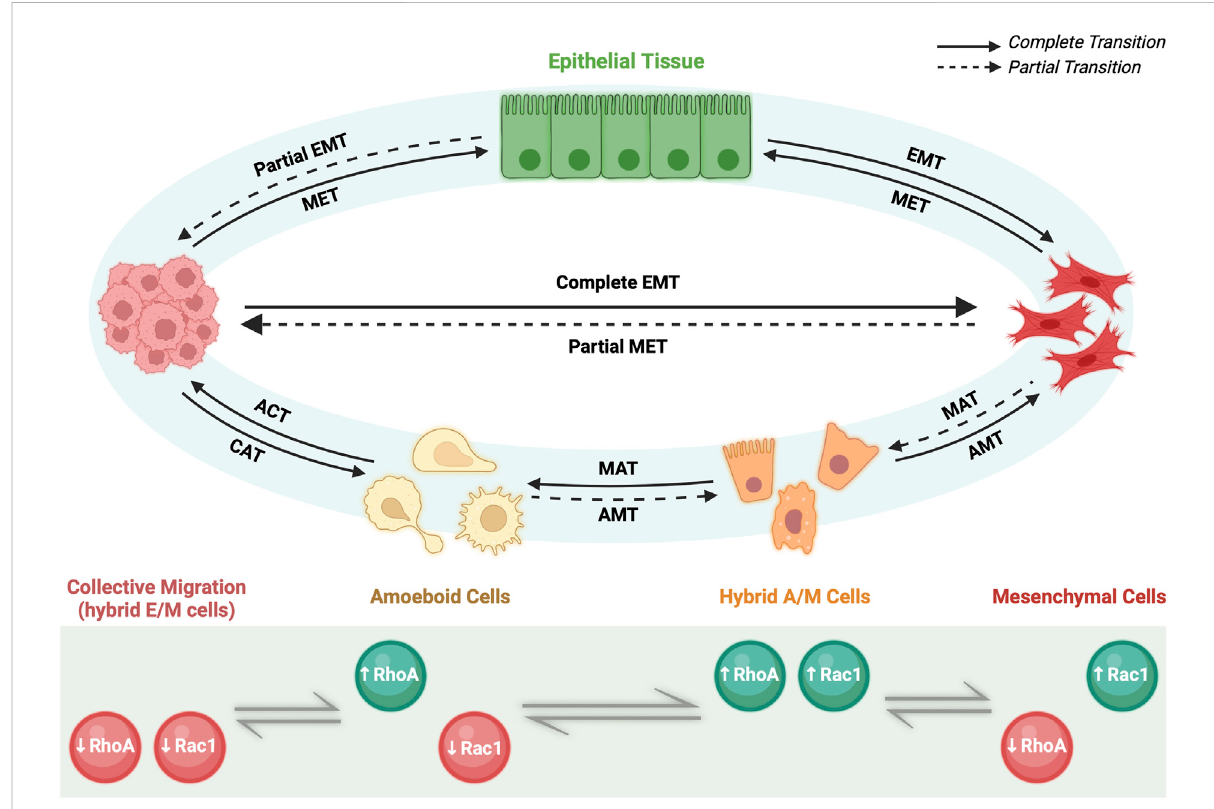
FIGURE 3 Migratory plasticity. Primary epithelial tissue through partial EMT (pEMT) and complete EMT can give rise to motile cells capable of invasion via collectivemigrationofhybridE/Mcellsorindividualmigrationofmesenchymalcells,respectively.Afterwards,speci fi cmicroenvironmentconditions govern reversible cell fates. On one hand, cluster of hybrid E/M cells can undergo collective-individual transition either by completing EMT process and becoming mesenchymal cells or via collective-amoeboid transition (CAT) and giving rise to amoeboid cells. The reverse process is called amoeboid-collective transition (ACT). Amoeboid and mesenchymal cells can reversibly interchange phenotype via amoeboid-mesenchymal (AMT) and mesenchymal-amoeboid transition (MAT), respectively. Partial AMT and partial MAT give rise to hybrid A/M cells with mixed amoeboid and mesenchymal features. On the other hand, mesenchymal cells via pEMT can either undergo individual-collective migration giving rise to a cluster of migratory hybrid E/M cells or revert their phenotype via MET and becoming epithelial cells. All the transitions rely on thelevels of two small GTPases, RhoA and Rac1, which can be upregulated (green) or downregulated (red) depending on the cell